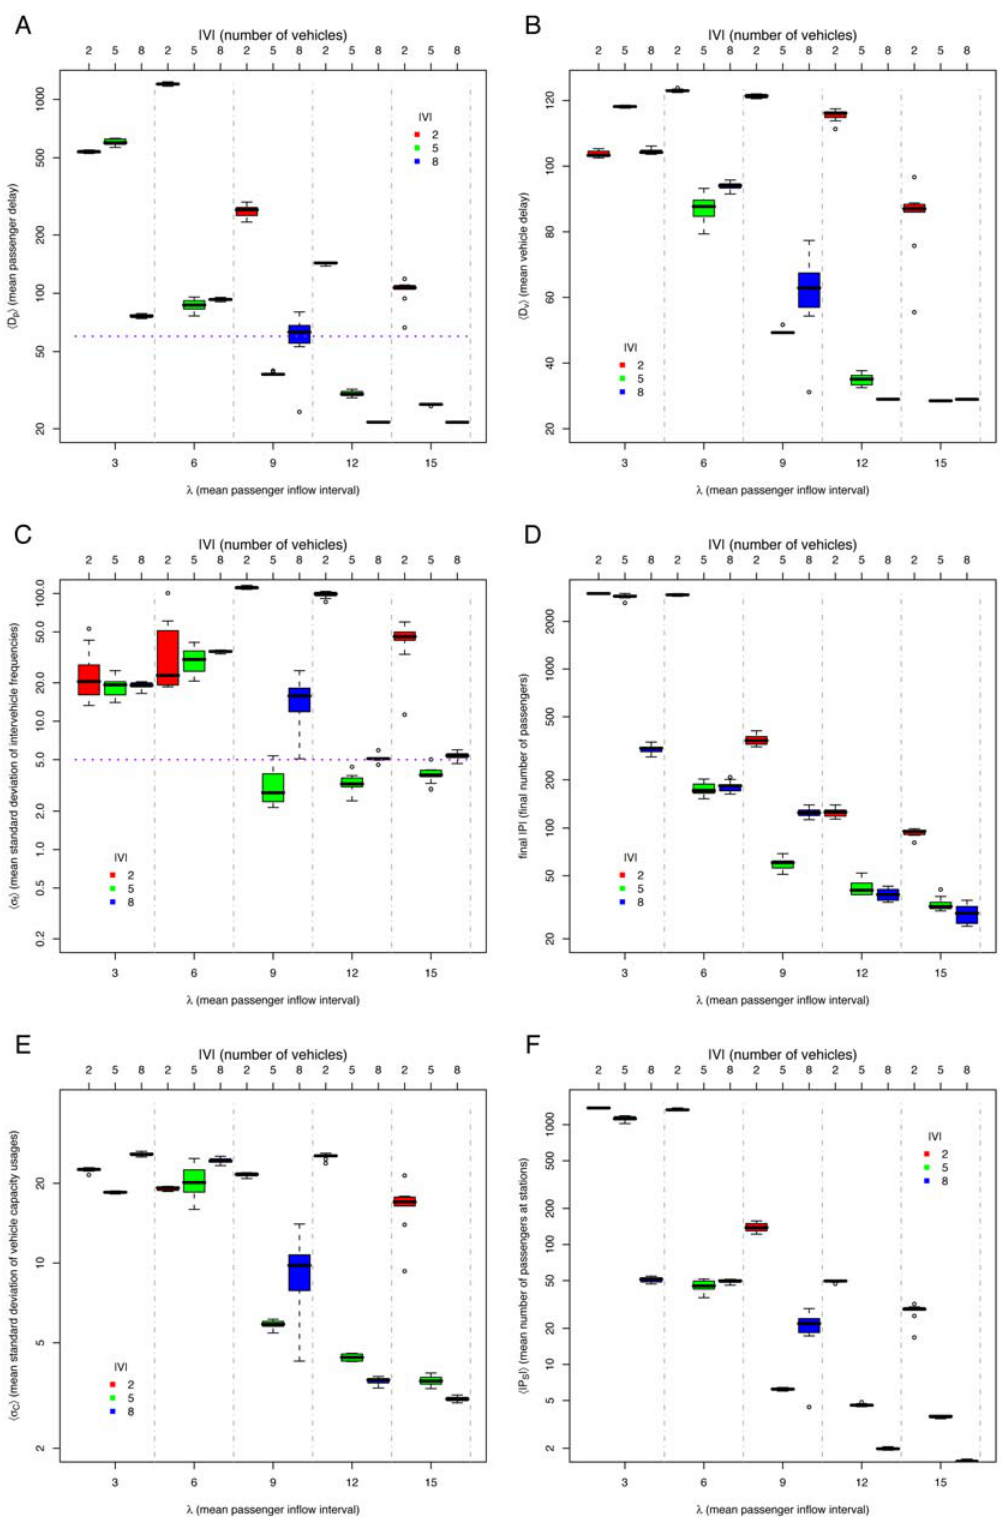
Figure 10. Simulation results for adaptiveminimum method , varying mean passenger inflow intervals l (lower x axis, separated by vertical dashed lines) and number of vehicles V j j (upper x axis, also indicated by color of boxes): (A) mean passenger delay S D p T (data above horizontal dotted line indicates poor system performance), (B) mean vehicle delay S D v T , (C) mean standard deviation of intervehicle frequencies S s f T (data above horizontal dotted line implies unstable headways), (D) final number of passengers P j j , (E) mean standard deviation of vehicle capacity usage S s C T , and (F) mean number of passengers at stations S P s j j T .